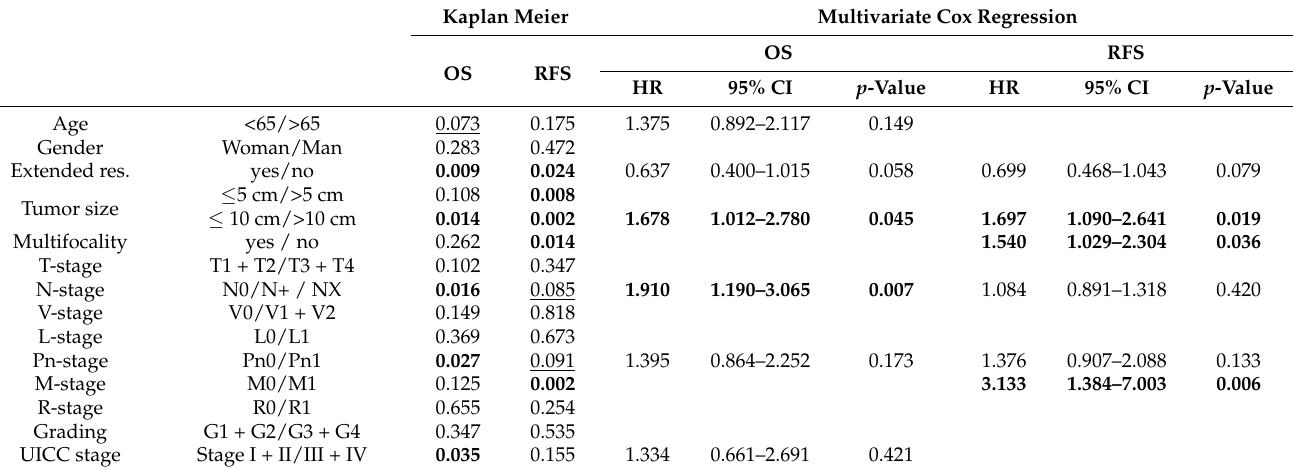
Table 2. Univariate and multivariate